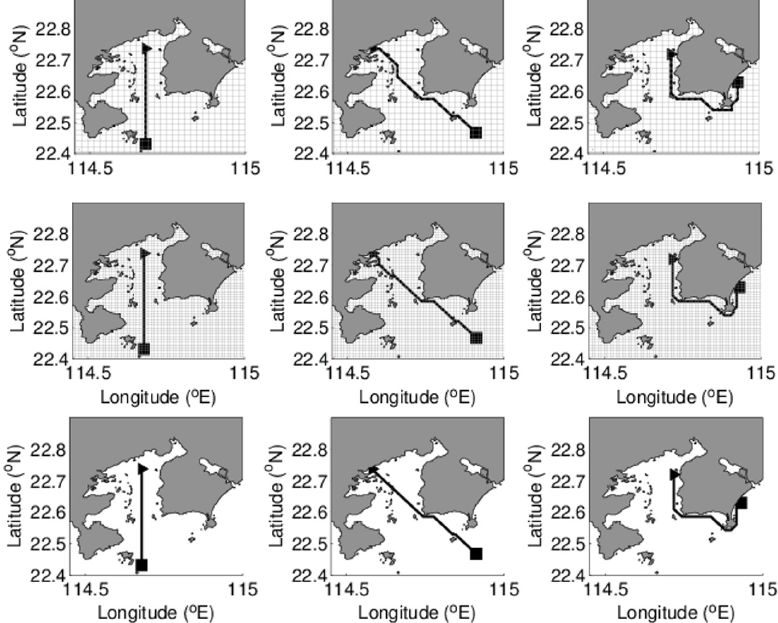
Figure 5. The comparison of the optimal paths for different spatial resolutions. The thick black lines are the optimal paths predicted by the MDP algorithm. The triangles indicate the starting point, and the squares are the target. The grid size of 2000 m is used for the top panels, 1000 m for the middle, and 200 m for the bottom. The left, middle and right panels represent Case 1, 2, and 3, respectively. Table 3. Algorithm performances for different spatial resolutions.